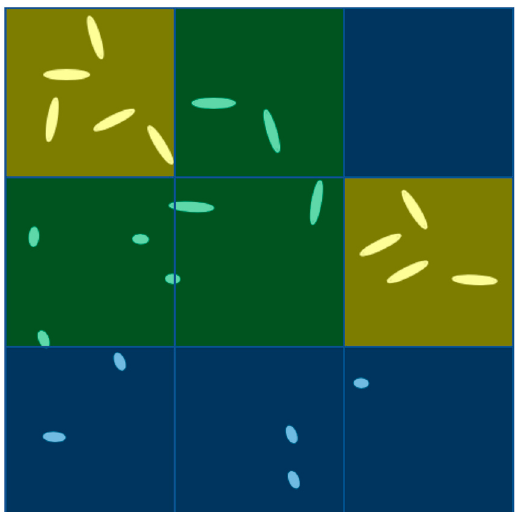
Figure 2. Schematic diagram of a precipitate image divided into square boxes and colored according to the degree of auto-tempering. The apparent local area fraction of auto-tempered carbides decreases from yellow through green to blue.